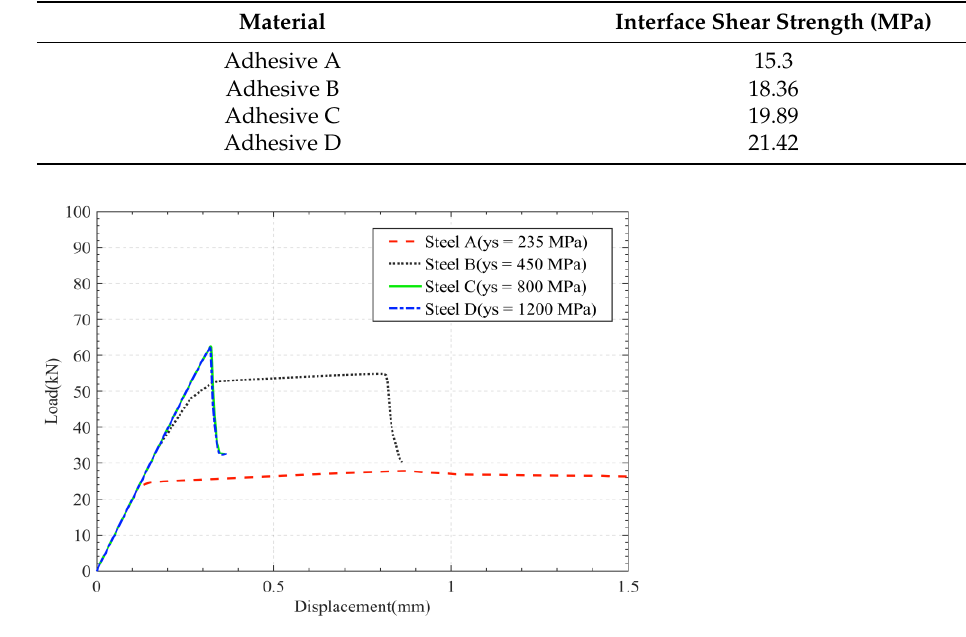
Figure 13. The load – displacement of the anchorage system consists of different steel wire. Figure 13. The load–displacement of the anchorage system consists of different steel wire.